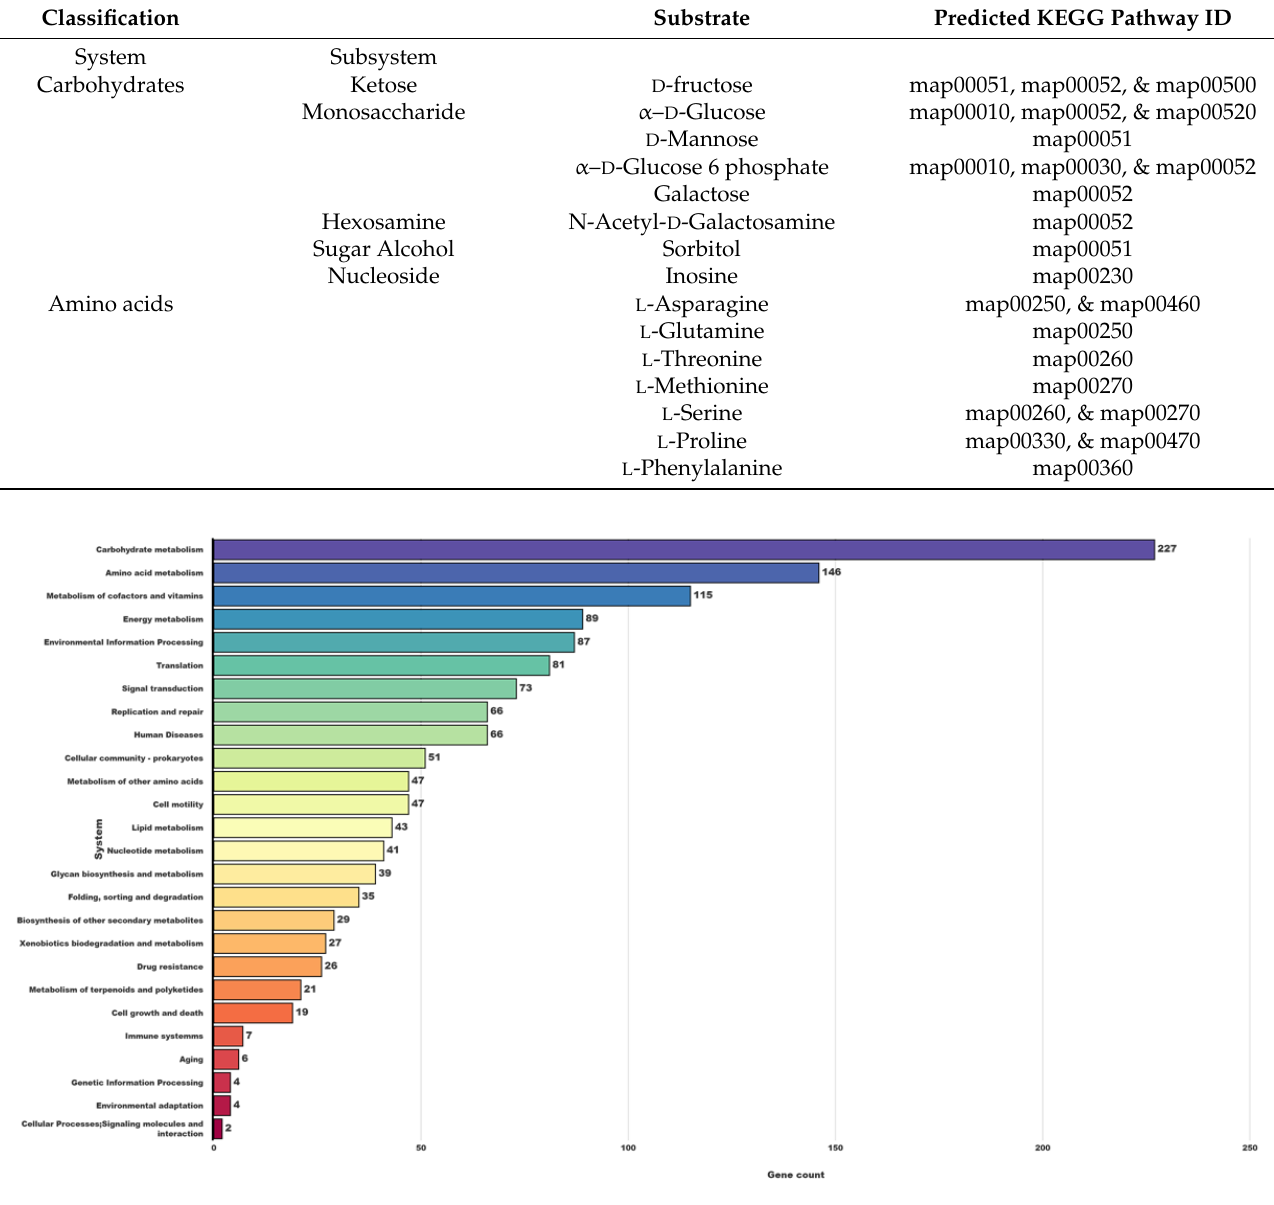
Figure 5. Kyoto Encyclopedia of Genes and Genomes (KEGG) classification of metabolic pathways P. bifermentans